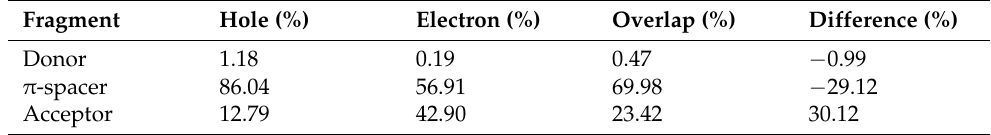
Table 5. Fragment contribution to electron–hole overlap in O2 .